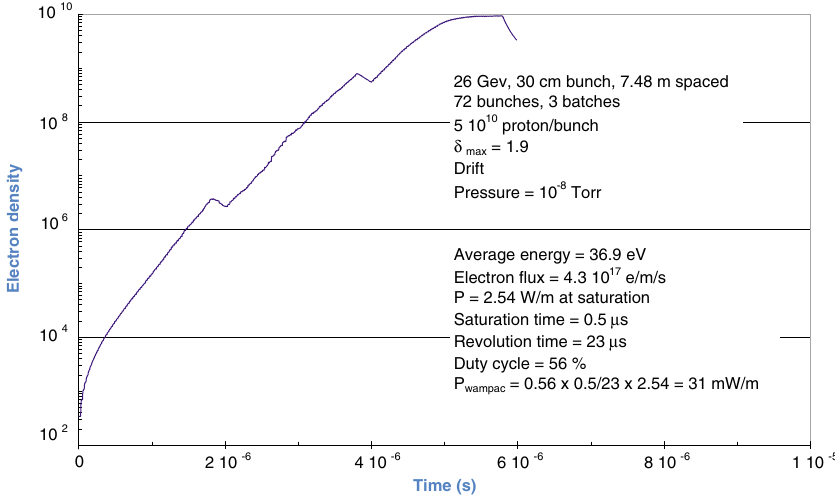
FIG. 7. (Color) Electron density in WAMPAC computed for a maximum SEYof